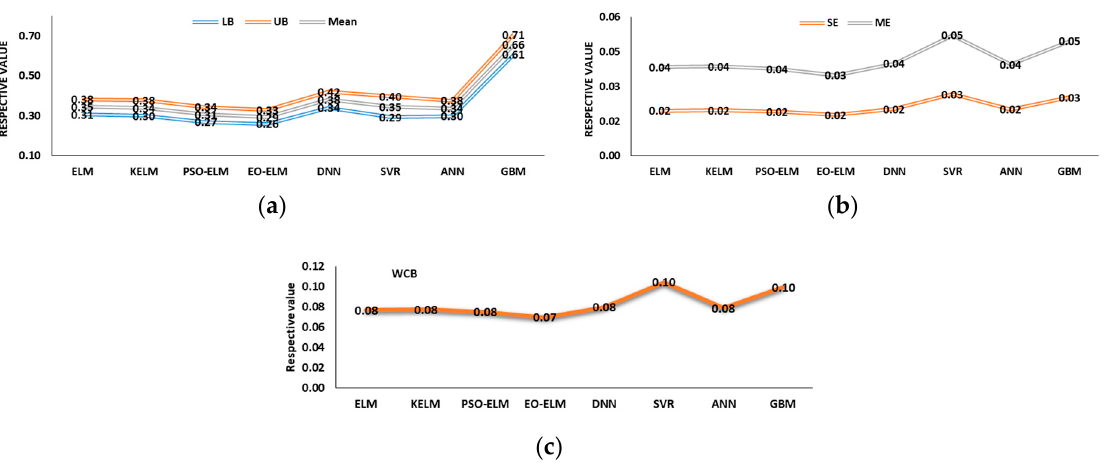
Figure 20. Visual representation of UA for lag-based models (Fal at Tregony), ( a ) lower bound (LB), upper bound (UB) and mean; ( b ) standard error (SE) and margin of error (ME); ( c ) WCB.